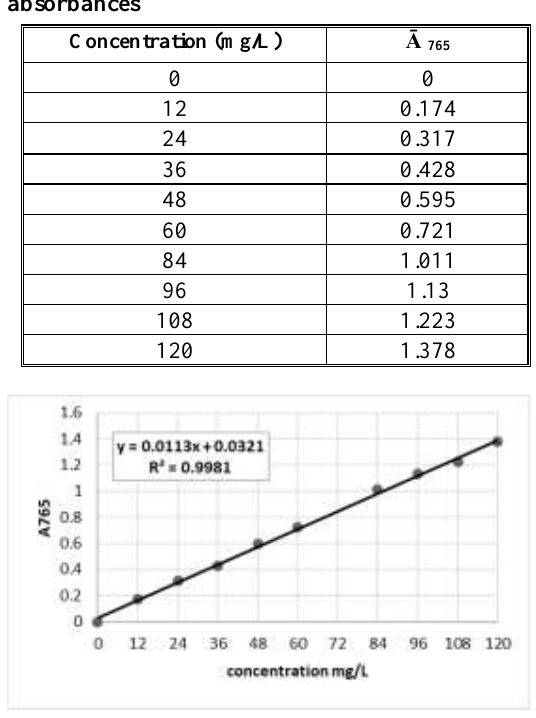
Figure 1.Gallic acid calibration